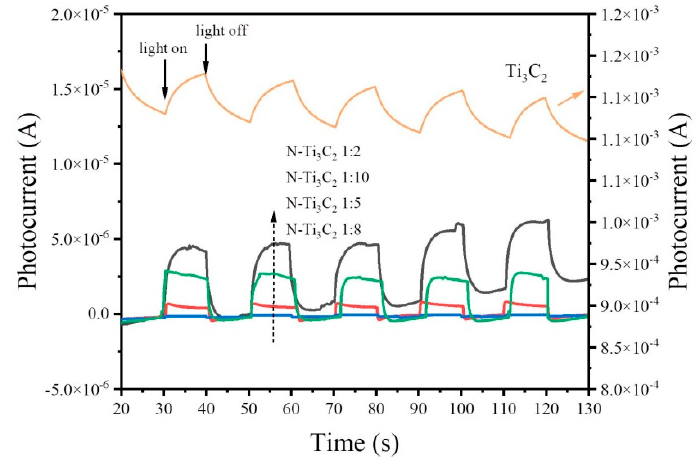
Figure 6. Transient photocurrents of Ti 3 C 2 and N − Ti 3 C 2